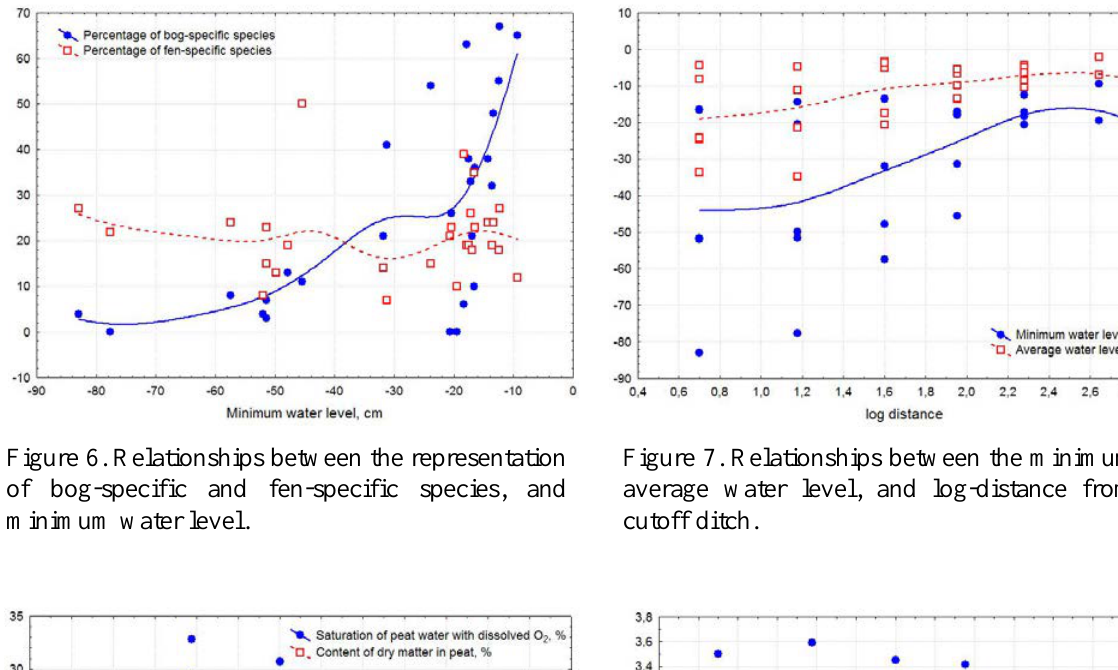
Figure 9. Relationship between the total-N content in soil and log-distance from the cutoff